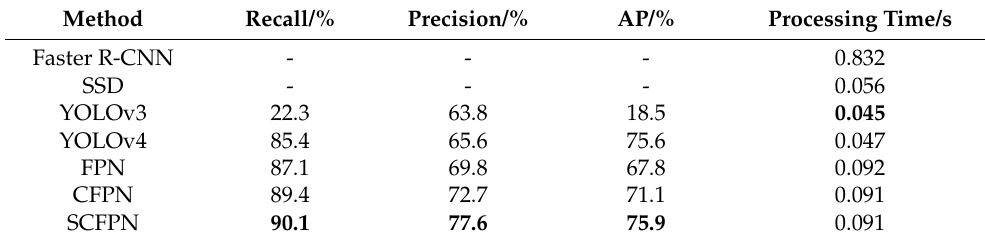
Table 4. Roll mark detection experiment evaluation metrics of different detection networks on CSU_STEEL. The bolded values are the best results in their respective columns. Method Recall/% Precision/% AP/% Processing Time/s Faster R-CNN -